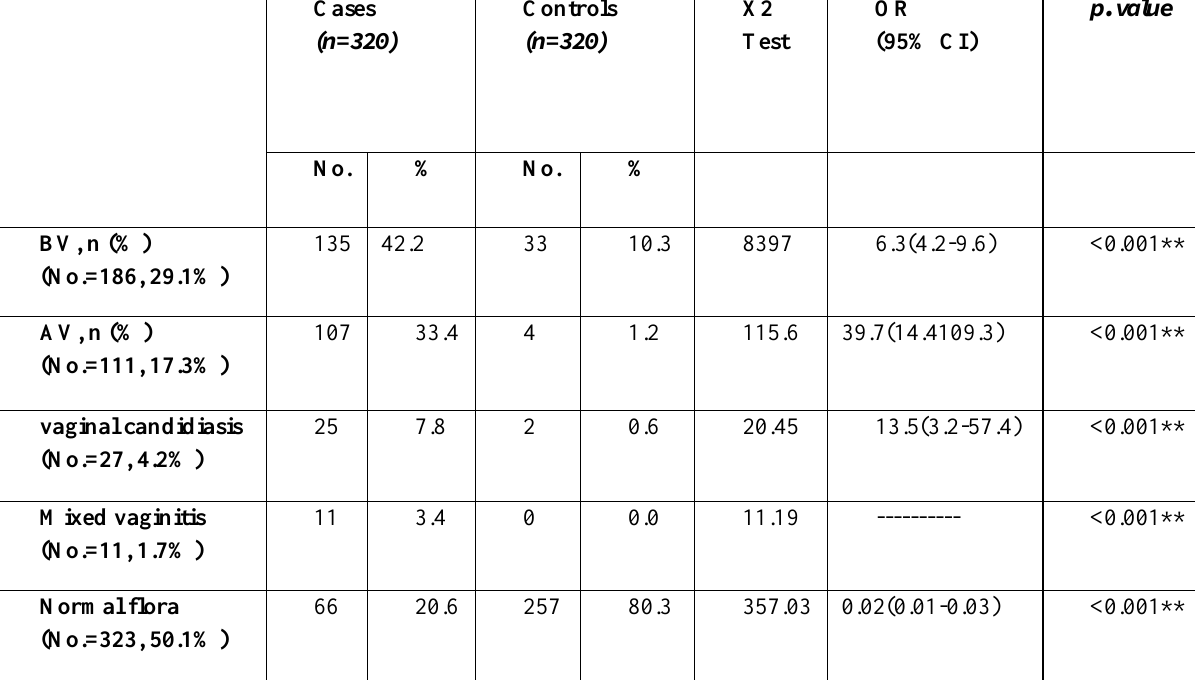
Table 2. Prevalence of vaginal infections and normal vaginal flora among case and control groups assessed